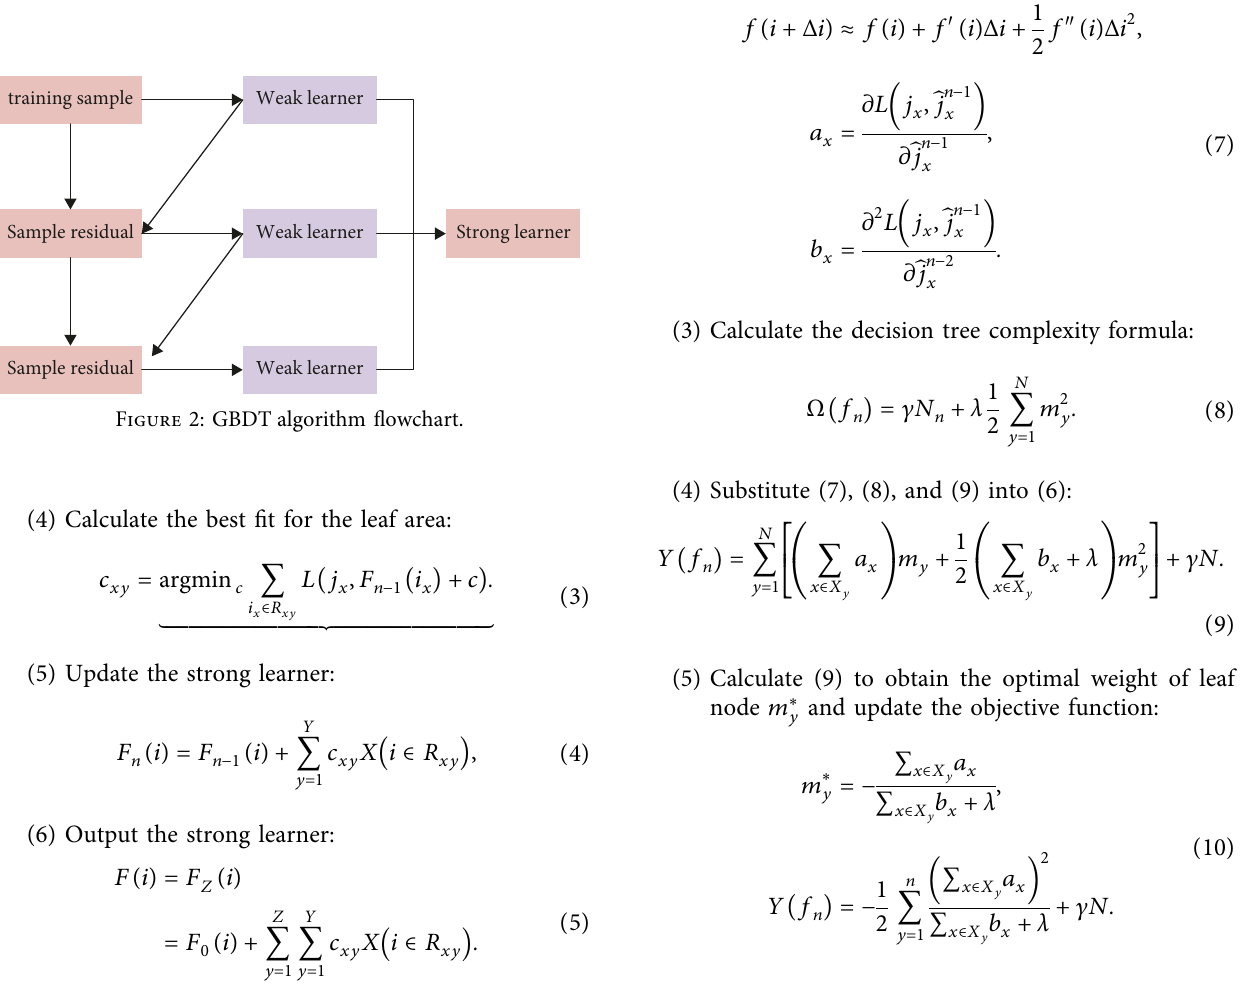
Figure 1: Parallelization process of SP-RF